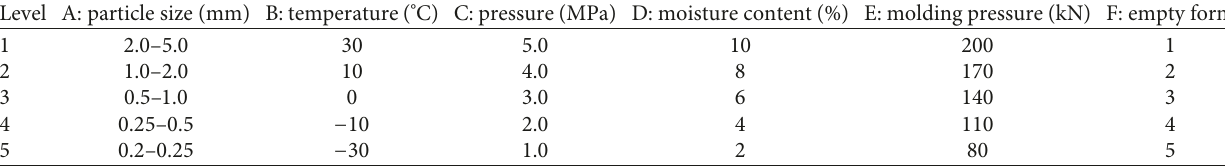
Table 2: Factors and levels of orthogonal experiment L25 (5 6 ).